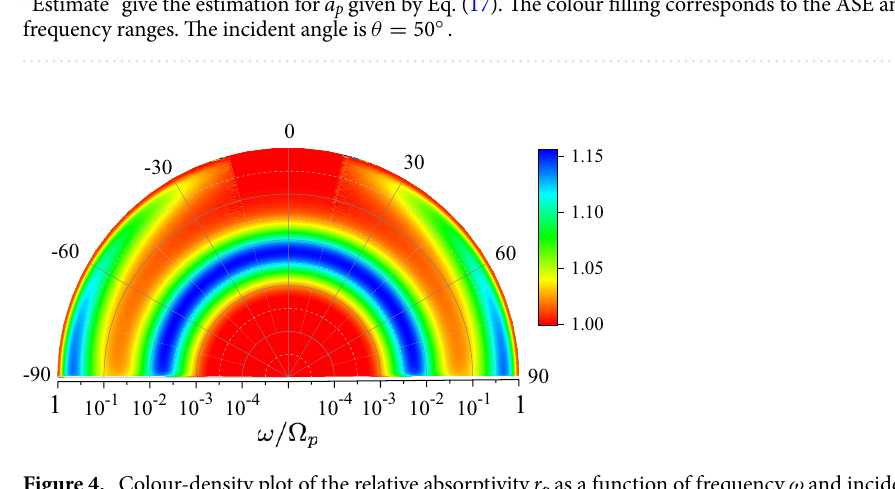
Figure 4. Colour-density plot of the relative absorptivity r p as a function of frequency ω and incident angle θ for 3 5 10 α − = ×